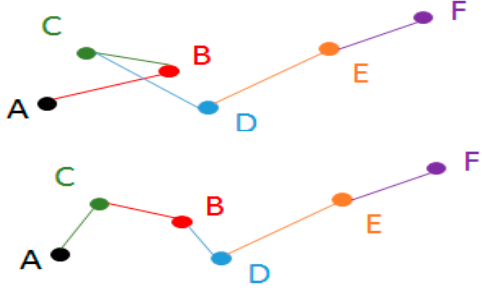
Figure 18. The 2-opt method.